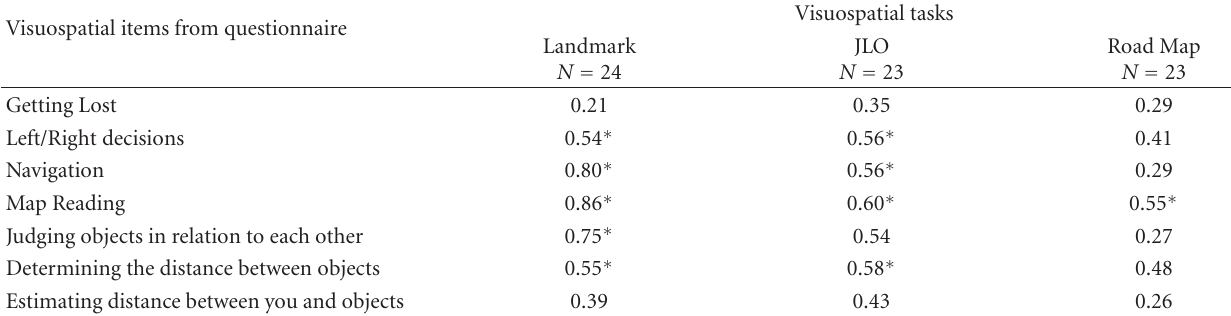
Table 3: Content validation of visuospatial